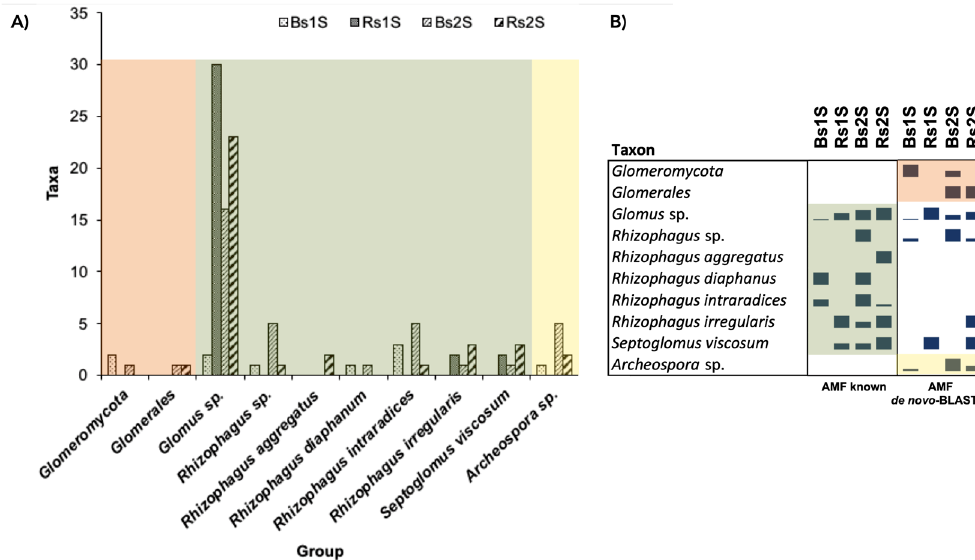
Figure 7. Taxa classification. ( A ) Number of sequences belonging to the different taxa - obtained grouping ″ AMF de novo -BLASTed ″ taxa with the ″ AMF known ″ ones, on the basis of the group to which they belonged - in the different compartments (Bs = Bulk soil, Rs = soil associated with the roots of V. vinifera cv. Pinot Noir) at the two sampling times (1 S = flowering and 2 S = fruit development). ( B ) Relative abundance of taxa, obtained considering separately “AMF known” and “AMF de novo -BLASTed”, belonging to each group, in Bulk soil (Bs) and in the soil associated with the roots of V. vinifera cv. Pinot Noir (Rs) at the two sampling times (1 S = flowering and 2 S = fruit development).